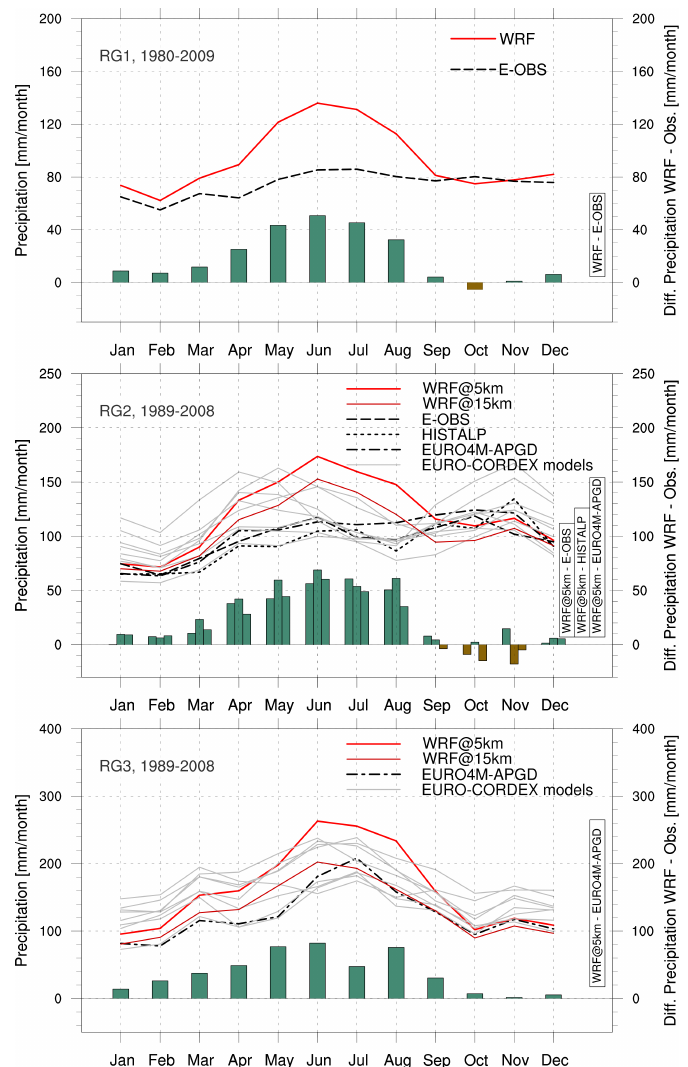
Figure 6. Mean annual cycle 1980–2009 (1980–2008 for EURO4M-APGD/1989–2008 where EURO-CORDEX is shown) of precipitation for the simulations and the observation datasets, and the monthly model bias averaged over RG1 (top), RG2 (center), and RG3